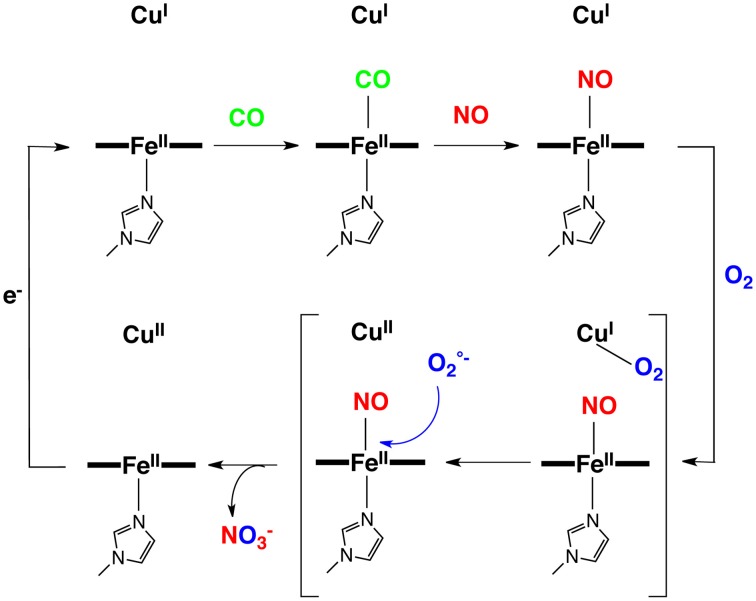
Proposed reaction mechanism for the CN, CO, NO inhibitions.